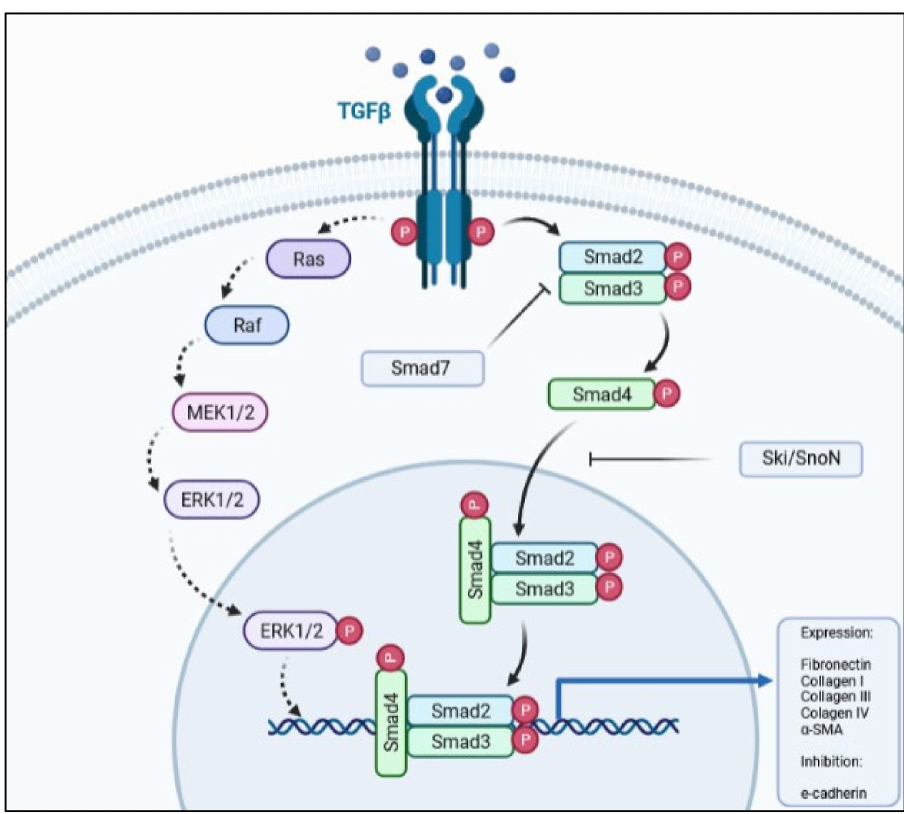
Figure 1. Simplified schematic representation of the TGF- β pathway, depicting the main proteins involved in signal